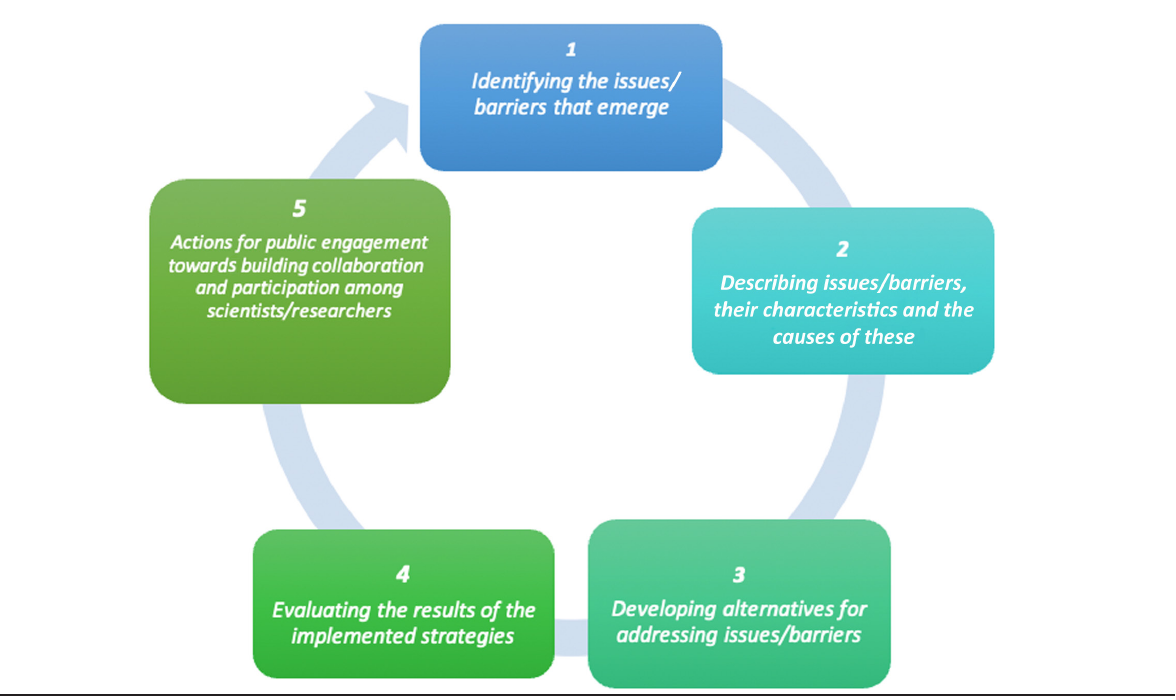
Figure 2. The action-reflection cycle process (Source: McNiff,